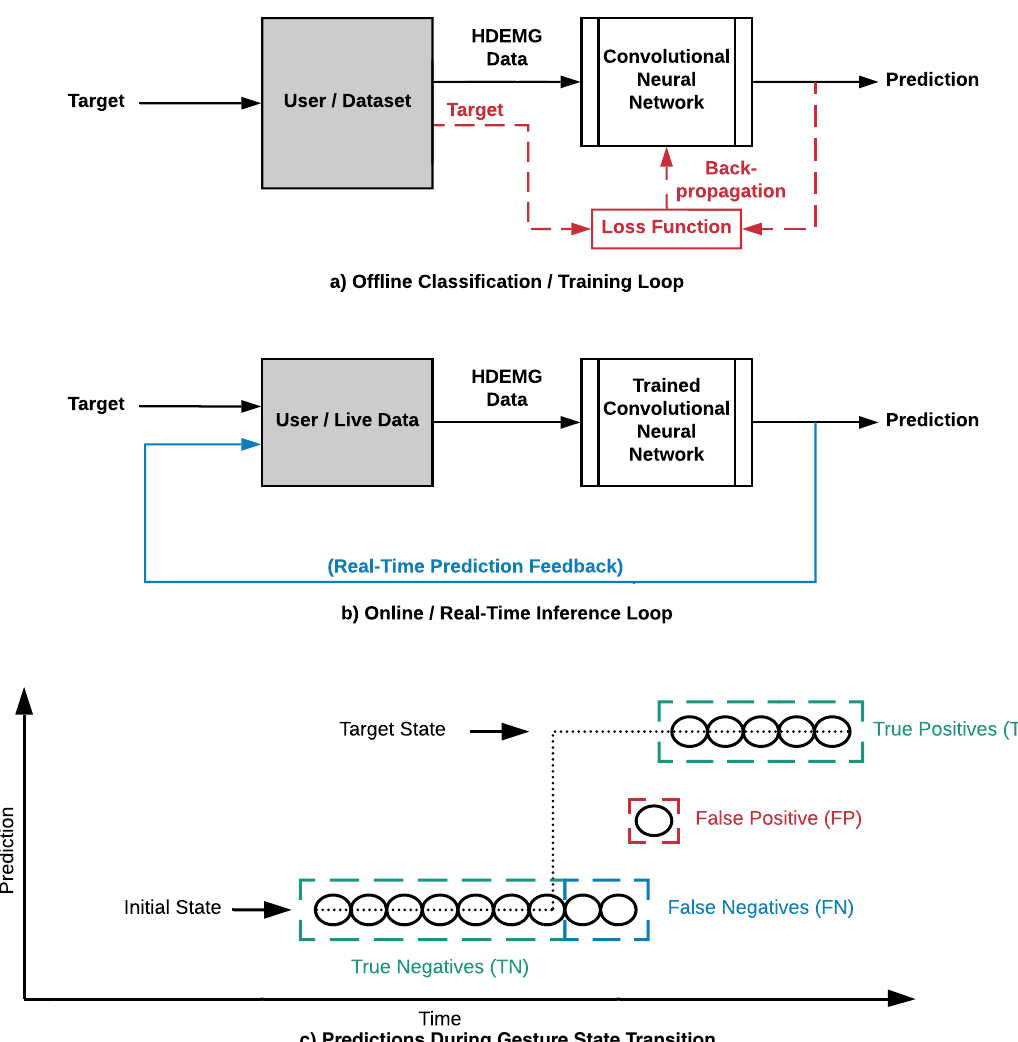
Figure 2. User interaction with the algorithm in offline and real-time scenarios. ( a ) Offline classification presents no user interaction with the algorithm. The user records a dataset, generating muscle contractions corresponding to target gestures. Data is then sent to the neural network with its output being compared to the recorded target label for training purposes. ( b ) The real-time inference loop allows for the user to react to the prediction feedback. Voluntary muscle contractions can be adjusted in order to maintain or change the predicted output. ( c ) Example of predictions during a gesture transition. Subsequent initial state predictions are considered true negatives (TN), and false negatives (FN) if the motion is engaged, but the prediction has not yet changed. Once a new gesture is predicted during the transition, the new prediction is considered a false positive (FP) if incorrect, or a true positive (TP) if